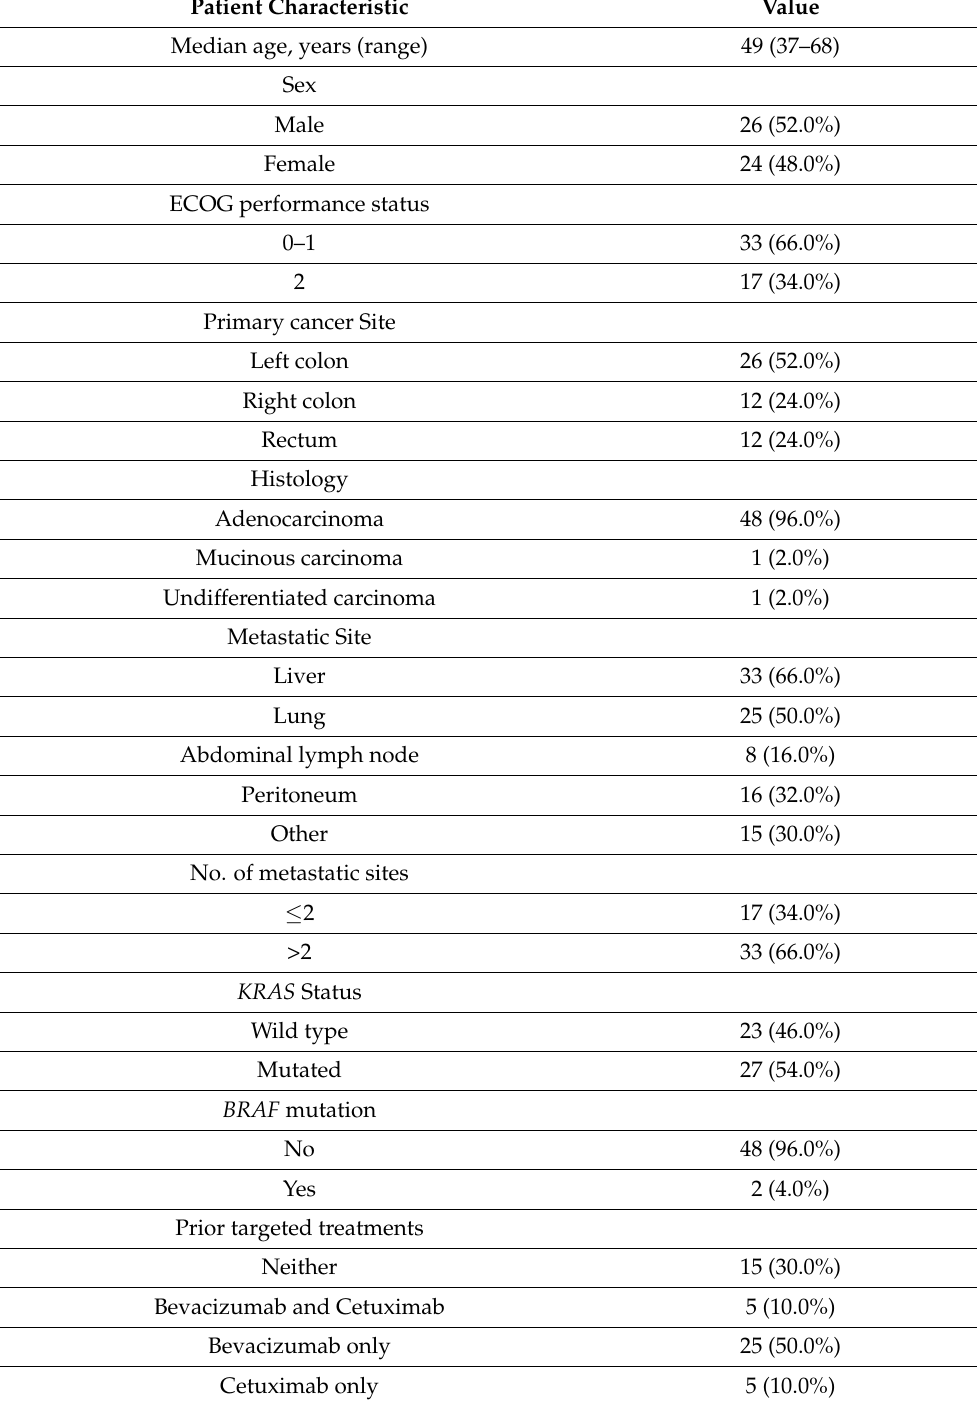
Table 1. Patients baseline characteristics ( n =